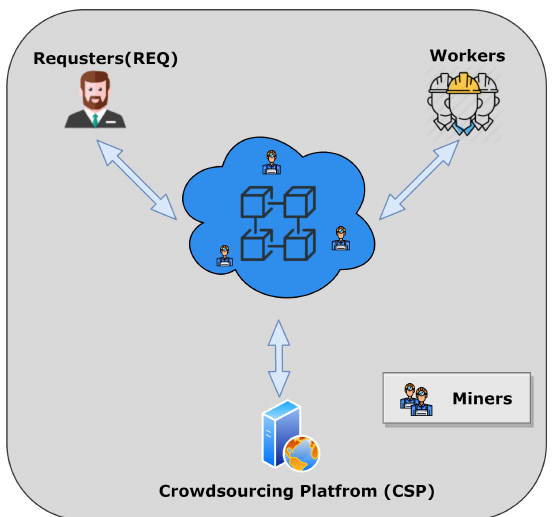
Figure 2. Overview of CrowdSFL. All participants interact via a P2P (peer-to-peer) network of